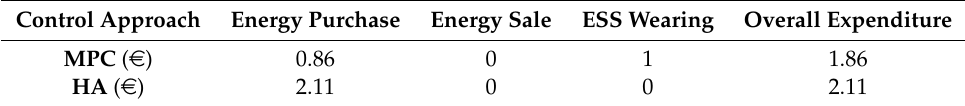
Table 1. Economic costs in a simulation of two days considering a simple